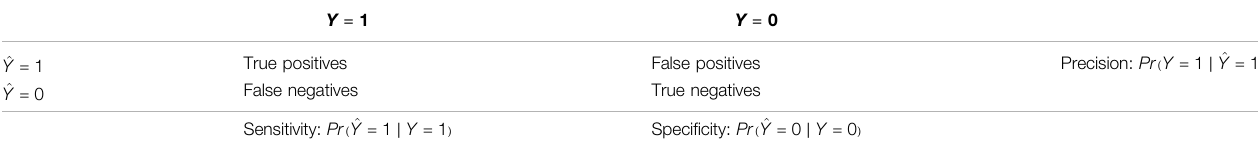
TABLE 1 | Confusion matrix and measures derived from it.